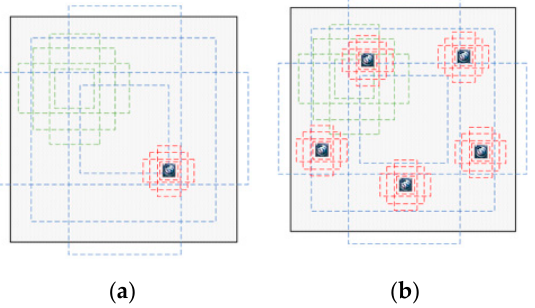
Figure 3. Anchors of different scales matching the ground truth objects; ( a ) Not using “copy-pasting” strategy; ( b ) Using “copy-pasting” strategy.